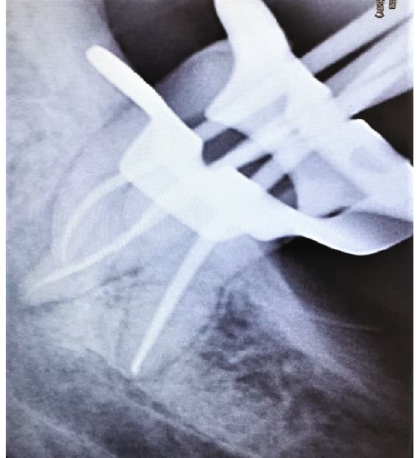
Figure 3: Master cone.